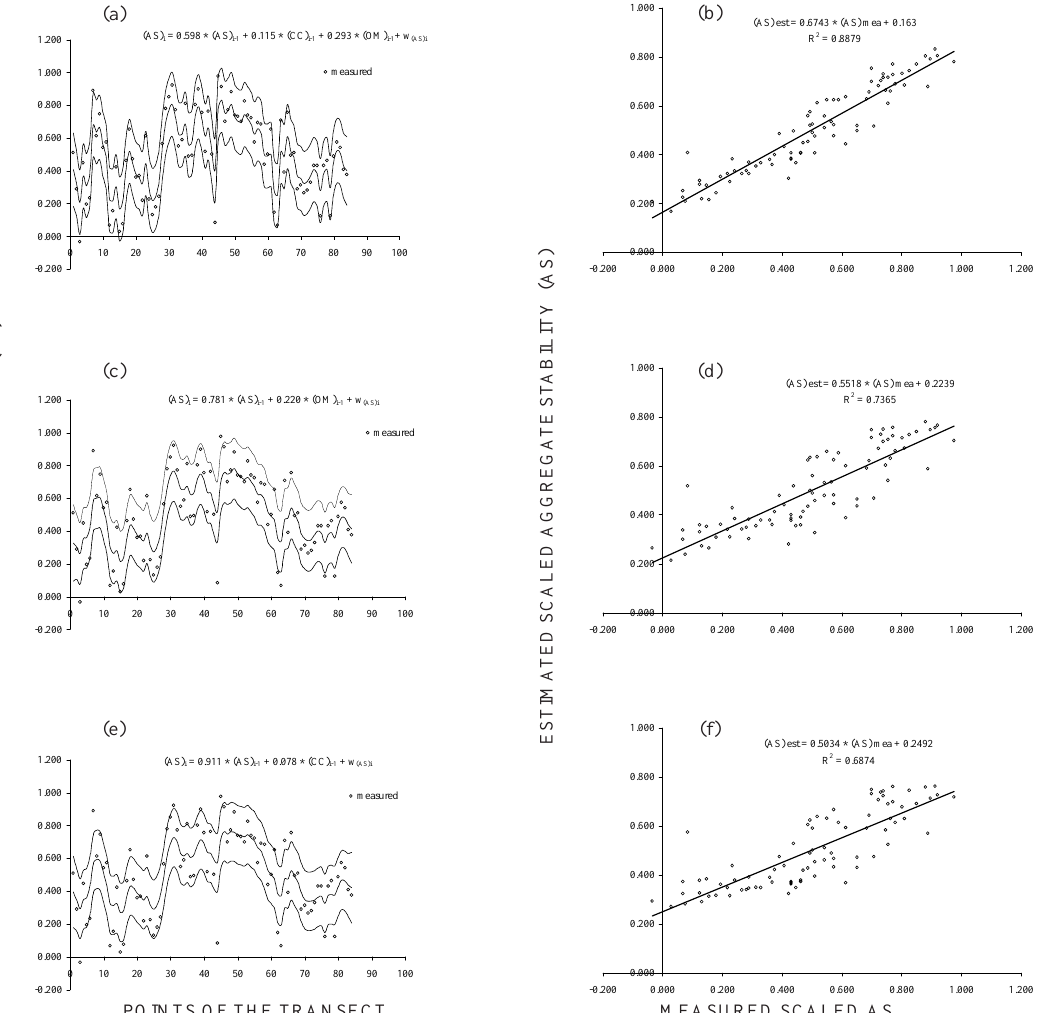
POINTS OF THE TRANSECT MEASURED SCALED AS Figure 8. State-space analysis of scaled original aggregate stability data: as a function of scaled original aggregate stability, scaled clay content residues and scaled soil organic matter residues, all at location i-1 (a); correlation between estimated and measured scaled original aggregate stability data of (a) (b); as a function of scaled original aggregate stability and scaled soil organic matter residues, all at location i-1 (c); correlation between estimated and measured scaled original aggregate stability data of (c) (d); as a function of scaled original aggregate stability and scaled clay content residues, all at location i-1 (e); and correlation between estimated and measured scaled original aggregate stability data of (e) (f). Table 3. State-space equations of aggregate stability using the soil organic matter residues data, clay content residues data, and values of R 2 from linear regression between estimated and measured values of AS. All observations have been scaled using equation